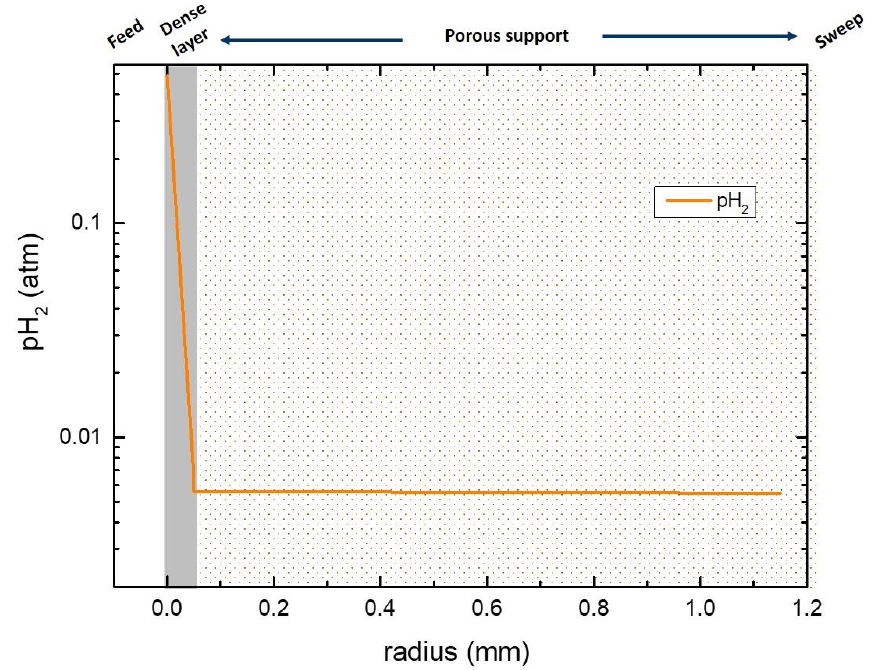
Figure 10. pH 2 distribution across the membrane layer and the porous support. The sweep is dry Ar, and the temperature is 900 °C.